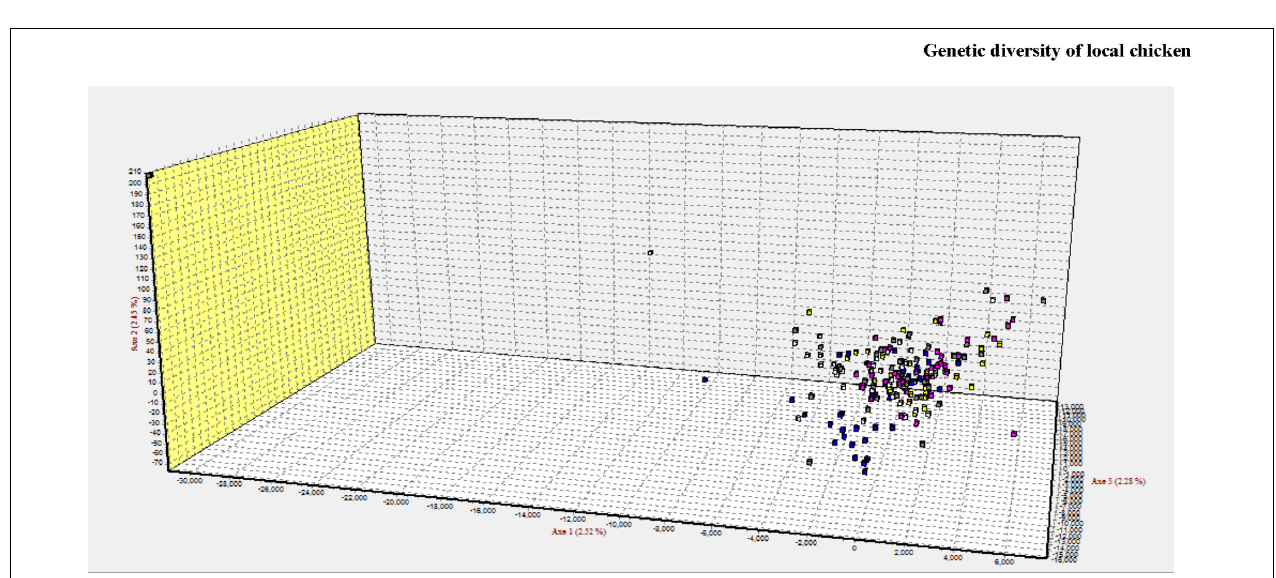
FIGURE 8 | Scatter plot showing the first three principal components over five village-based populations analyzed as revealed by principal component analysis (PCA) implemented in MVSP (Populations: DM, Dematagama; LA, Labunoruwa; OT, Ooththupitiya; TB, Tabbowa; TH, Thewanuwara).